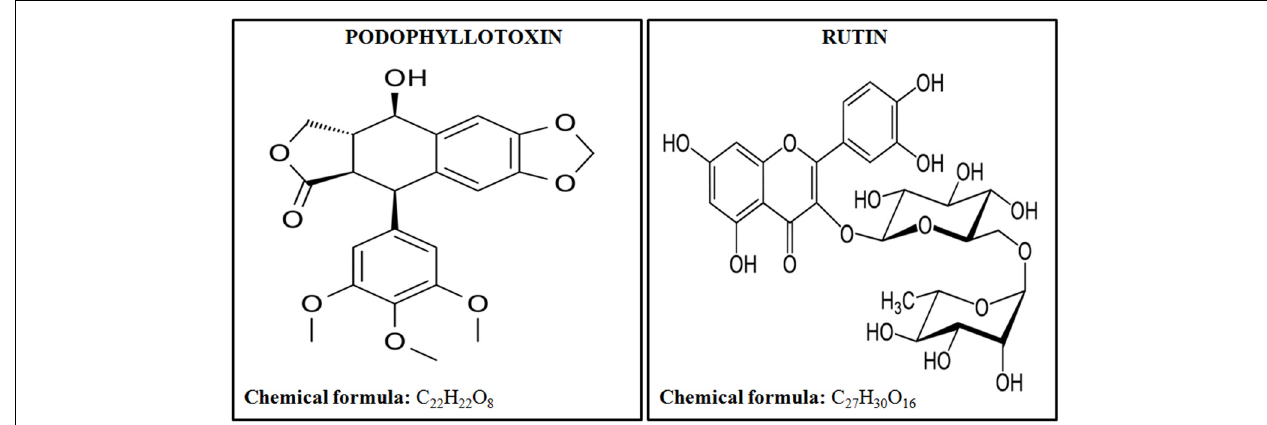
FIGURE 1 | Chemical structures and formulas of podophyllotoxin and